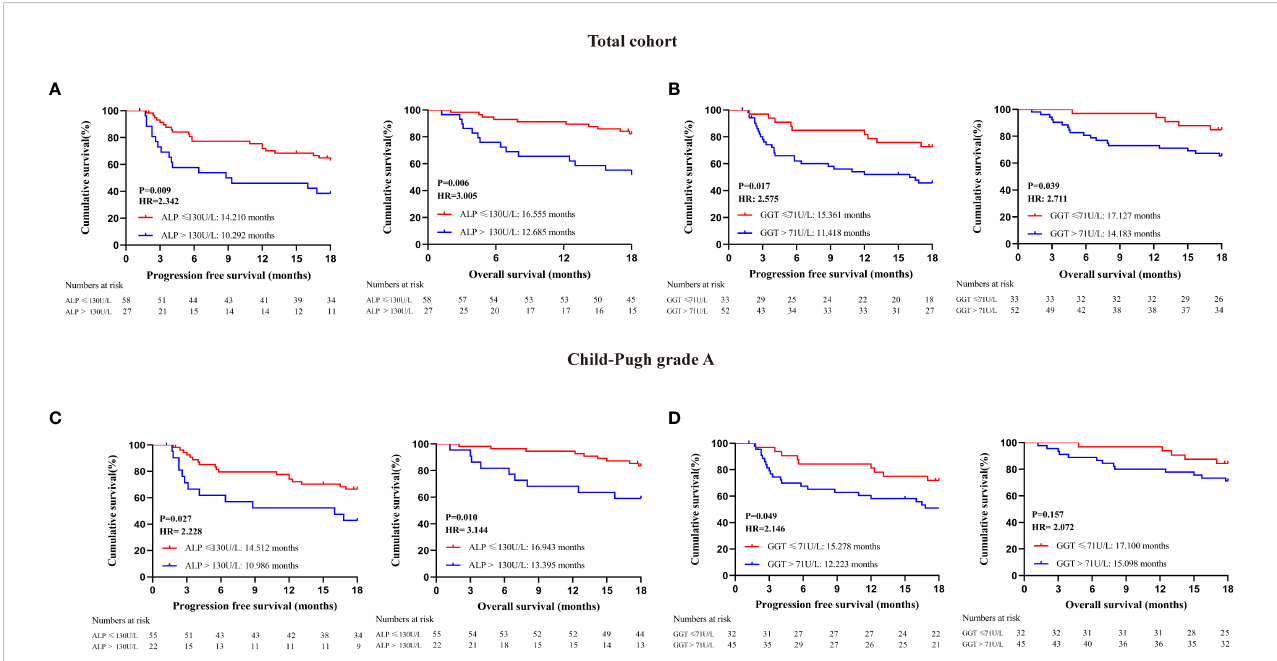
FIGURE 2 Prognostic analysis of patients receiving PD-1 inhibitors; (A) Survival analysis of all enrolled patients with different serum ALP levels at baseline: (B) Survival analysis of all enrolled patients with different serum GGT levels at baseline; (C) Survival analysis of patients with Child-Pugh grade A according to serum ALP levels at baseline; (D) Survival analysis of patients with Child-Pugh grade A according to serum GGT levels at baseline.